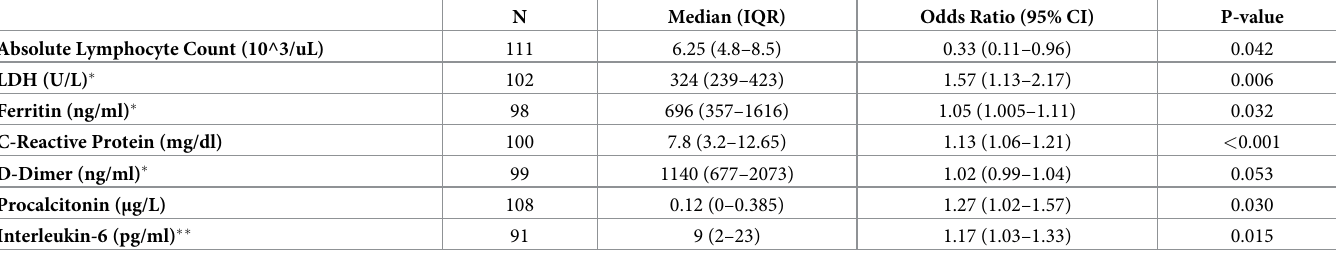
Table 2. Univariate logistic regression model for requiring mechanical